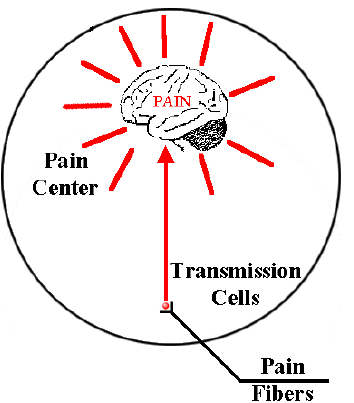
FIGURE 1 . Specificity theory. Peripheral nerve fibers deliver impulses to transmission cells that relay information to a proposed pain center in the